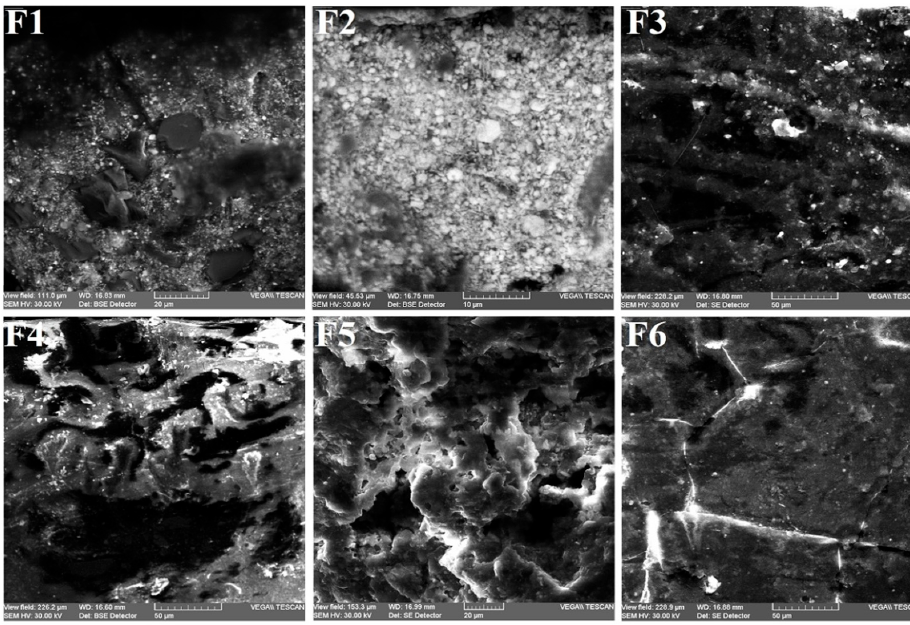
Figure 7. SEM microphotographs of the 6 samples: F1—blue background; F2—aureole; F3—carnage; F4—green background; F5—red garment; F6—blue garment.